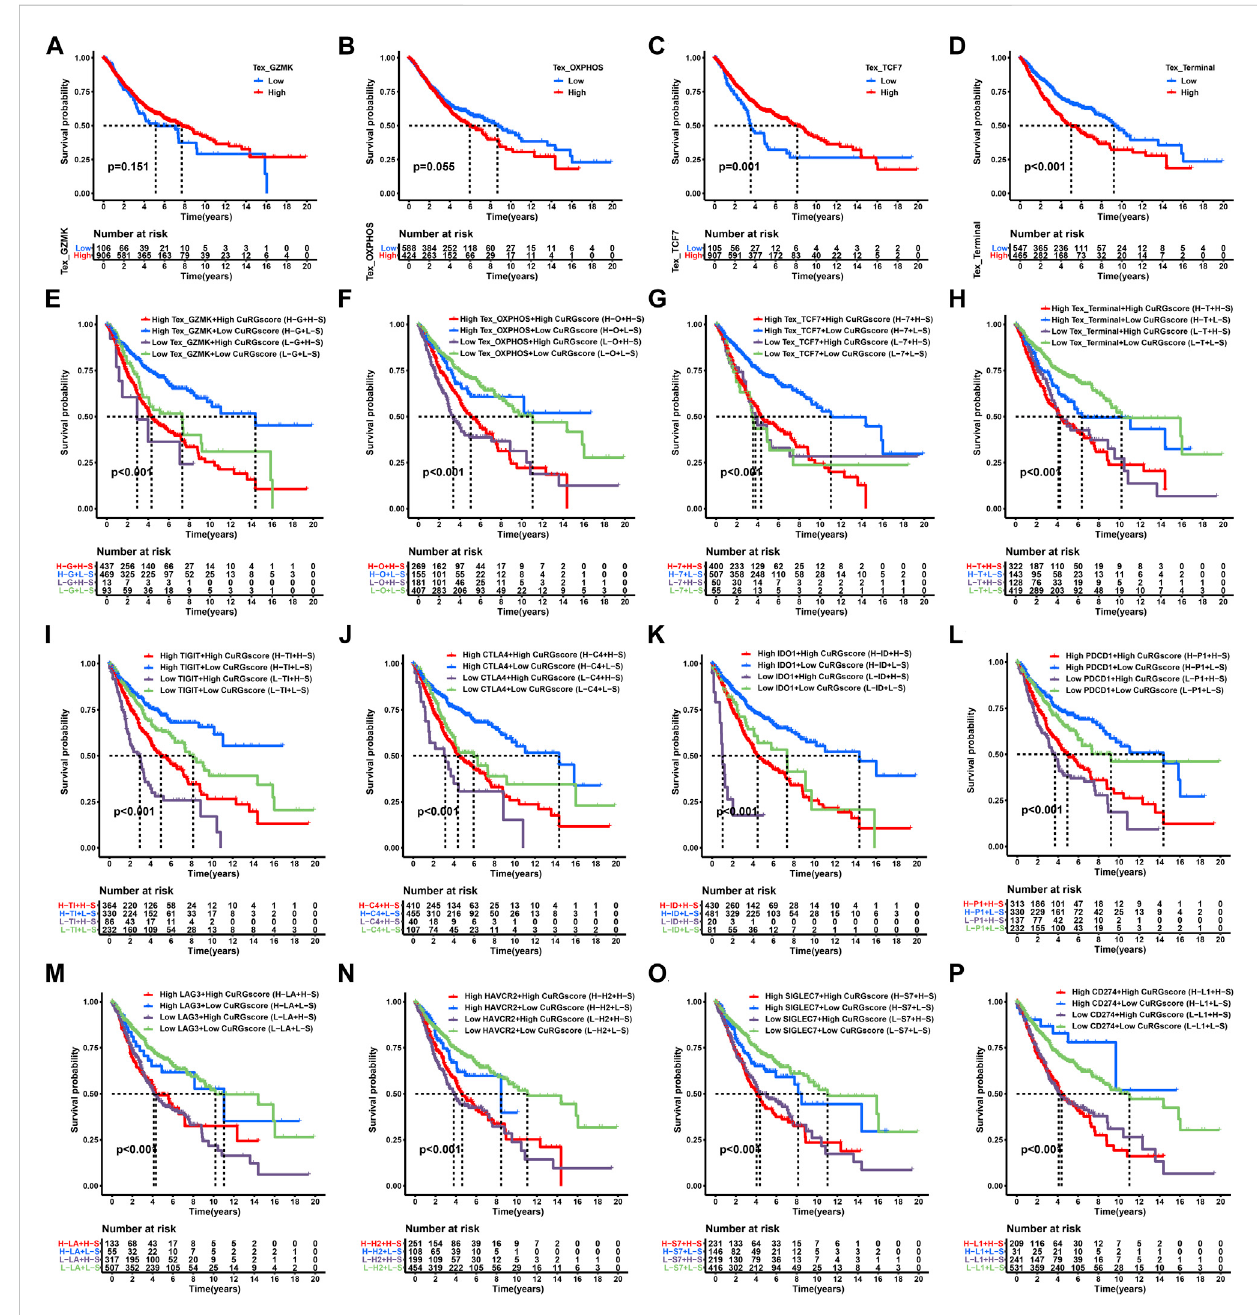
FIGURE 6 Survival analyses for subgroups of patients strati fi ed by CuRGscores and immune checkpoint genes in the training cohort. (A – D) Survival analysis to examine the OS of patients with LUAD in four TEX subtypes, including GZMK+ (A) , OXPHOS- (B) , TCF7+ (C) , and terminal TEX phenotypes (D) . (E – H) Prognosis analysis for patients with LUAD patients strati fi ed into four groups by CuRGscore and four TEX subtypes, including GZMK+ (E) , OXPHOS- (F) , TCF7+ (G) , and terminal TEX phenotypes (H) . (I – P) Kaplan-Meier curves analyzed the overall survival of patients with LUAD, strati fi ed into four groups by CuRGscores and checkpoint genes, such as TIGIT (I) , CTLA4 (J) , IDO1 (K) , LAG3 (L) , PDCD1 (M) , HAVCR2 (N) , SIGLEC7 (O) and CD274 (P)